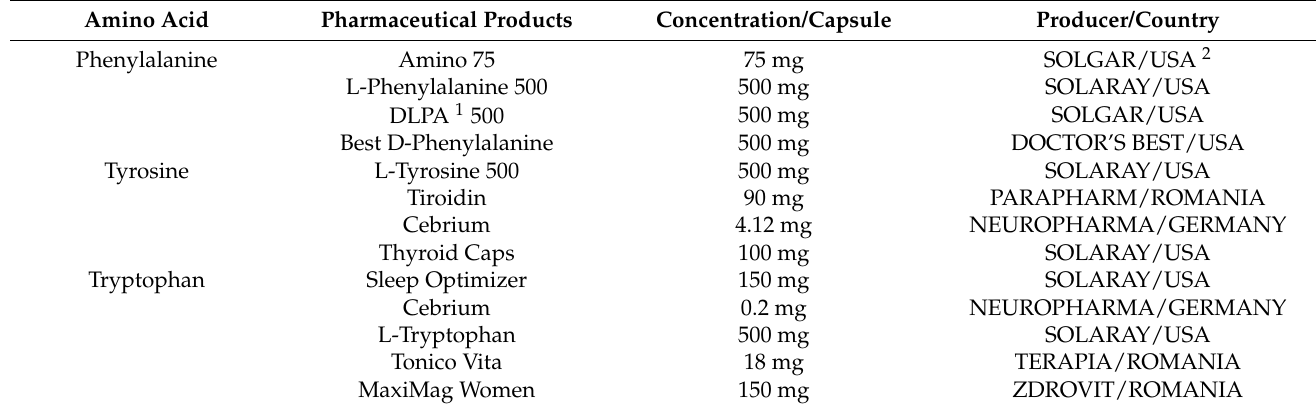
Table 2. Pharmaceutical products that contain amino acids Phe, Tyr, and Trypt.